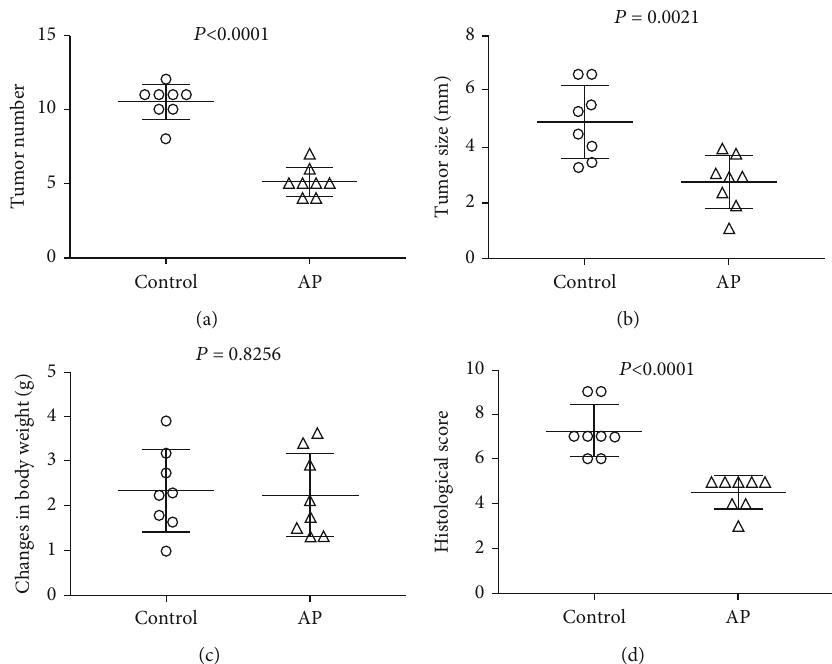
Figure 1: Apigenin decreased tumor morbidity in a CRC model related to colitis: the number (a) and size (b) of colon tumors in the control and AP groups, (c) change in body weight in the control and AP groups, and (d) histological score for the control and AP groups; n = 8